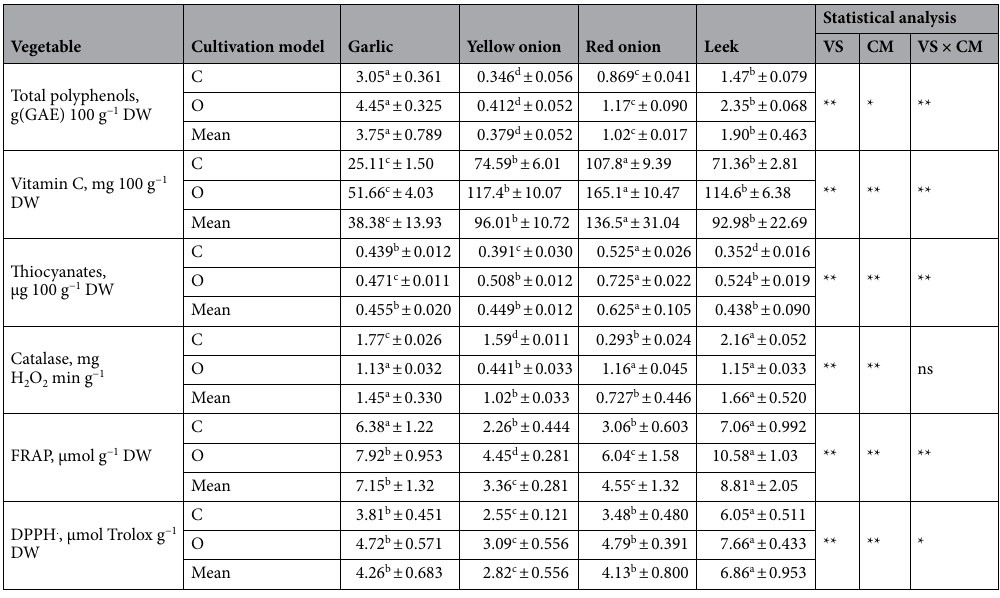
Table 2. Content of bioactive compounds and antioxidant activity in Allium vegetables depending on the cultivation model (conventional—C; organic—O). VS vegetable species, CM cultivation model (conventional vs. organic), ns no statistics. *Correlation significant at p ≤ 0.05 (one-way analysis). **Correlation significant at p ≤ 0.01 (one-way analysis). a,b ,c,d Values with different superscript letters in a row are significantly different at p ≤